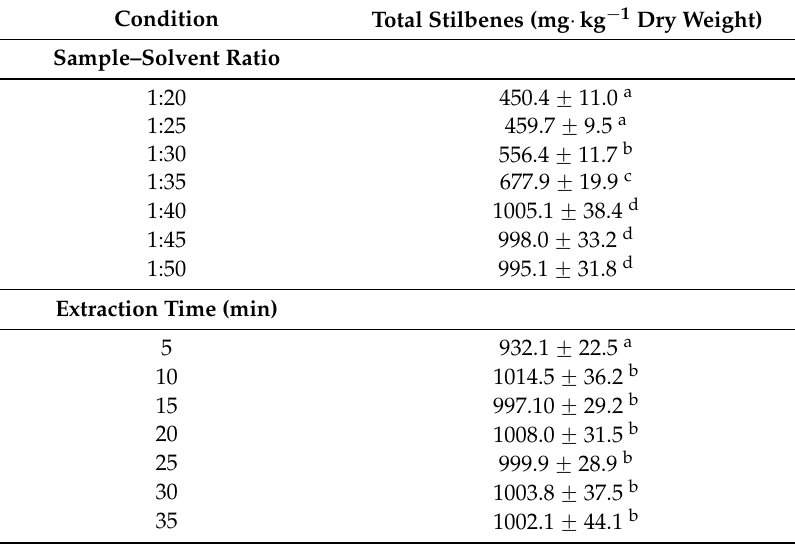
Table 2. Effects of different conditions on the extraction of total stilbenes ( n =